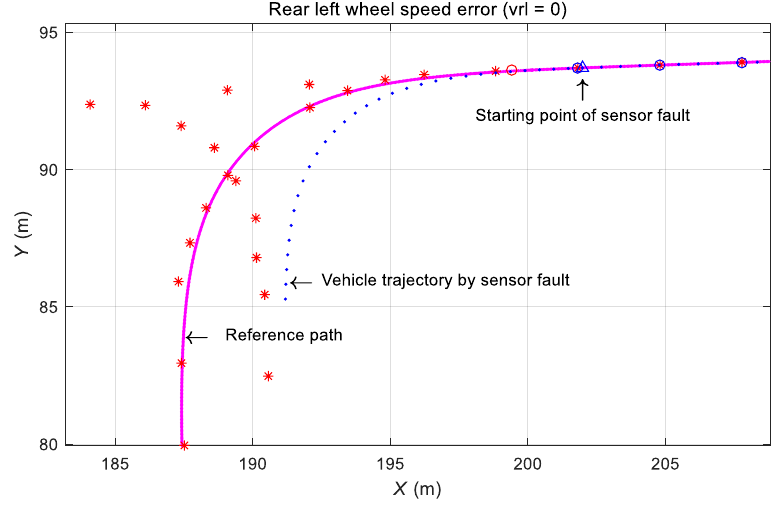
Figure 14. Test result for a wheel speed sensor fault.